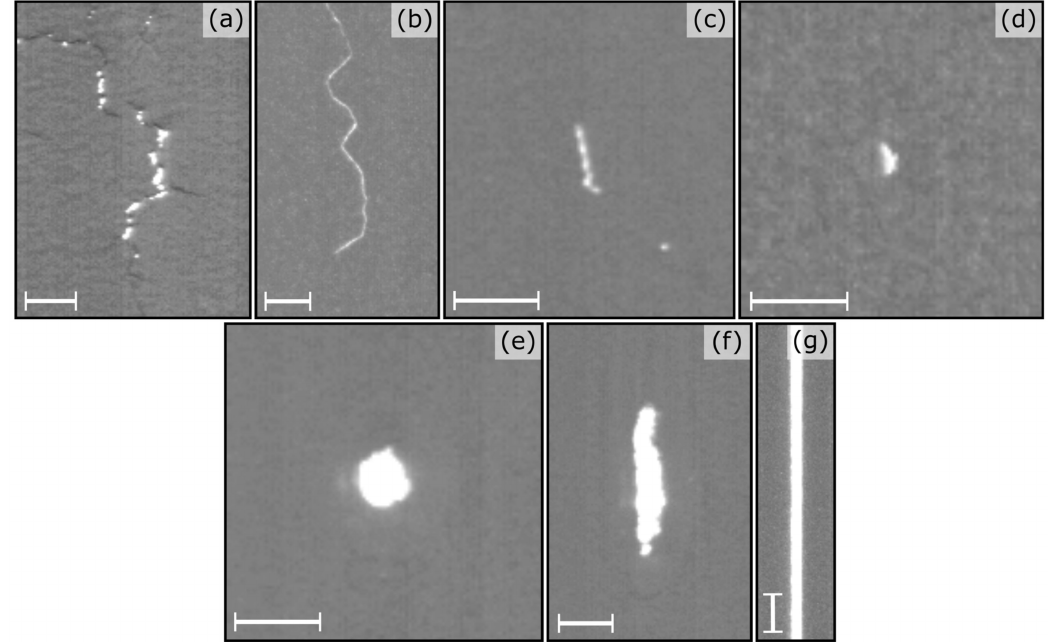
Figure 6. Exemplary defect pictures of different classes: ( a ) mud crack; ( b , c ) contamination (fluff); ( d – f ) pinhole and ( g ) stripe. The scale shown represents 1